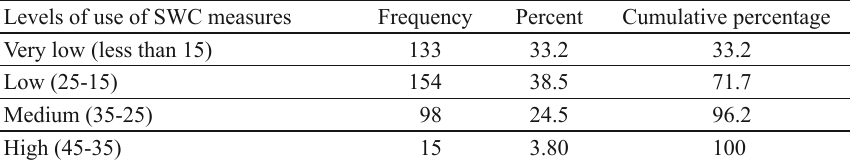
Distribution of farmers according to their use of SWC practices (n=400).